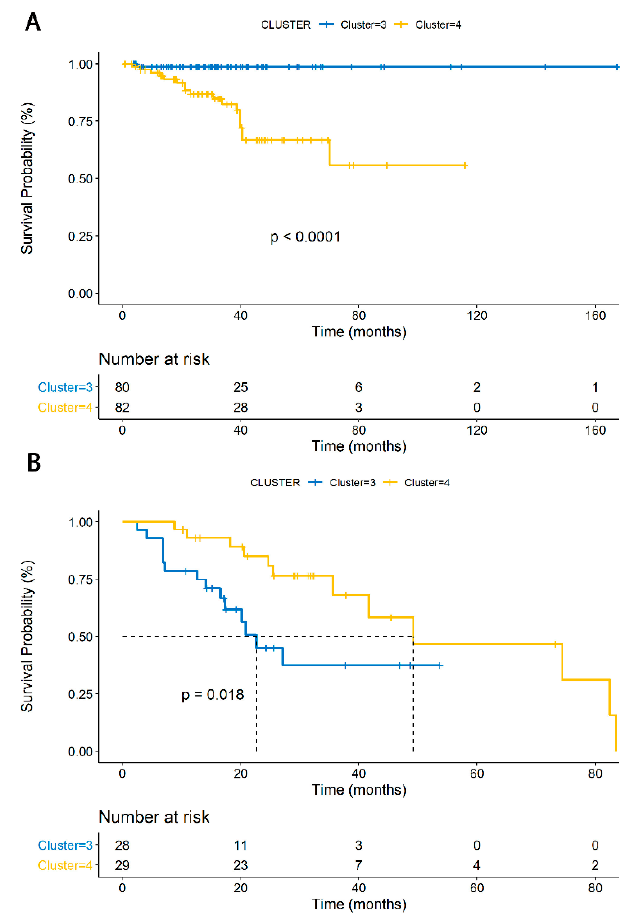
Figure 4. Panel ( A ) demonstrates progression-free survival for only patients receiving surgery in cluster 3 vs. 4, with cluster 4 displaying significantly worse progression-free survival (HR 18.1, 95% CI 2.41–135.5, p < 0.0001). Panel ( B ) displays progression-free survival for patients receiving both surgery and radiation in cluster 3 vs. 4, with cluster 3 displaying significantly worse progression-free survival (log-rank p = 0.018; HR 0.368, 95% CI 0.1568–0.8642, p = 0.0217). The Kaplan–Meier curves are color-coded, with figure legends at the top of each panel.